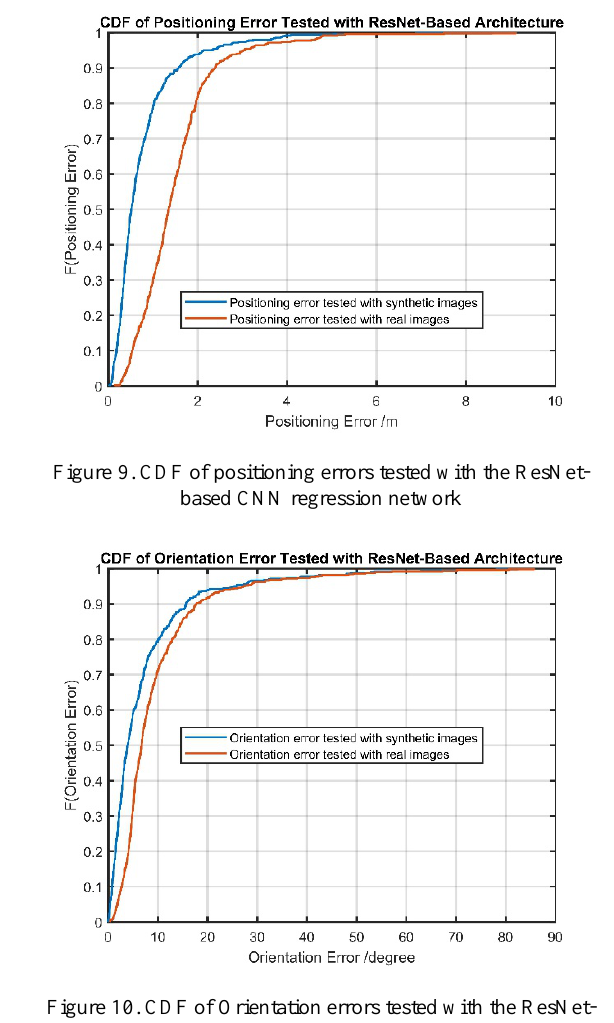
Figure 10. CDF of Orientation errors tested with the ResNet- based CNN regression